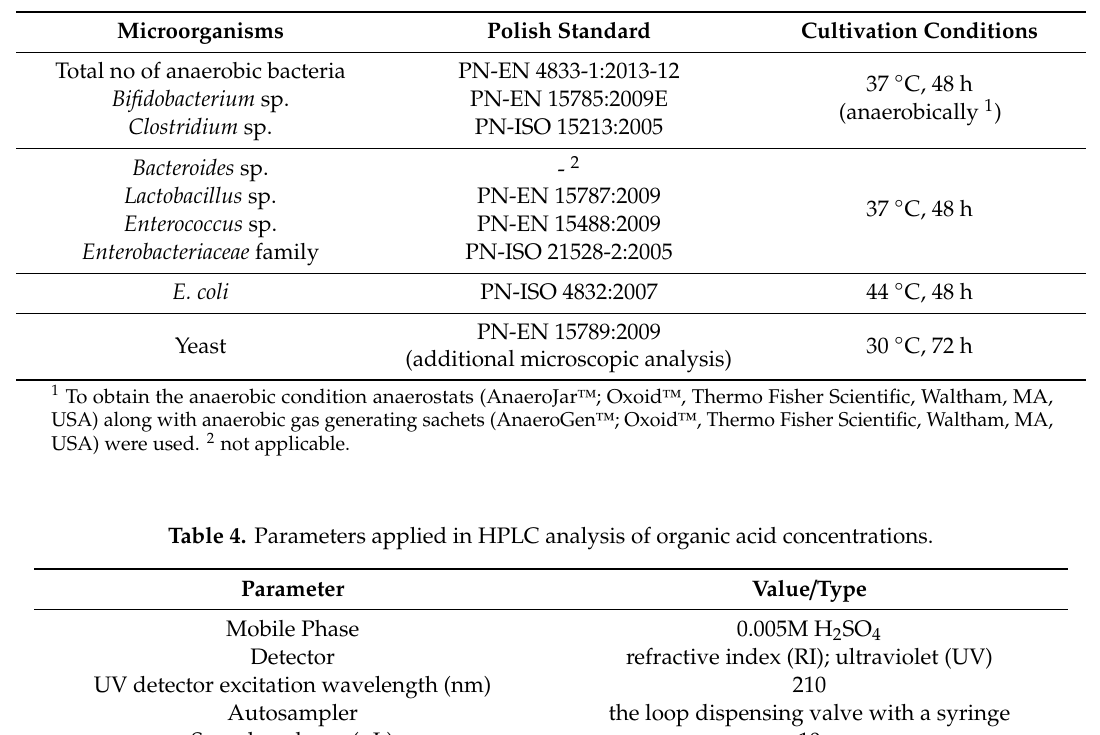
Table 3. Cultivation condition of analyzed microorganisms.